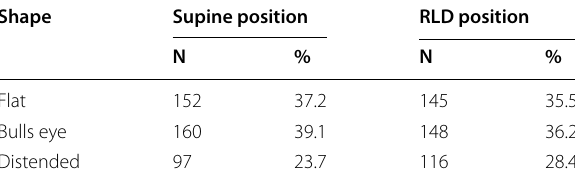
Table 2 Antral shape in supine and RLD position